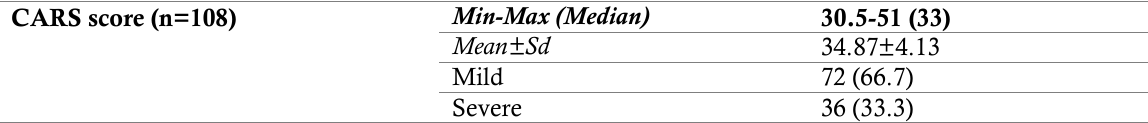
Table 3 . Distribution of CARS Scores of the Autistic Group